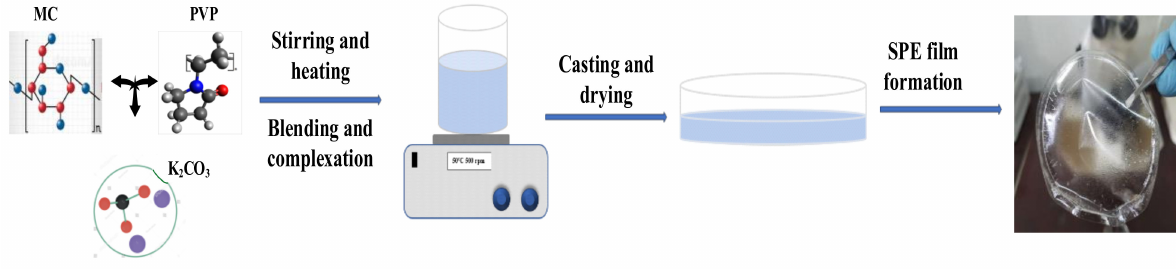
Figure 2. Flow diagram showing the preparation of MC/PVP/K 2 CO 3